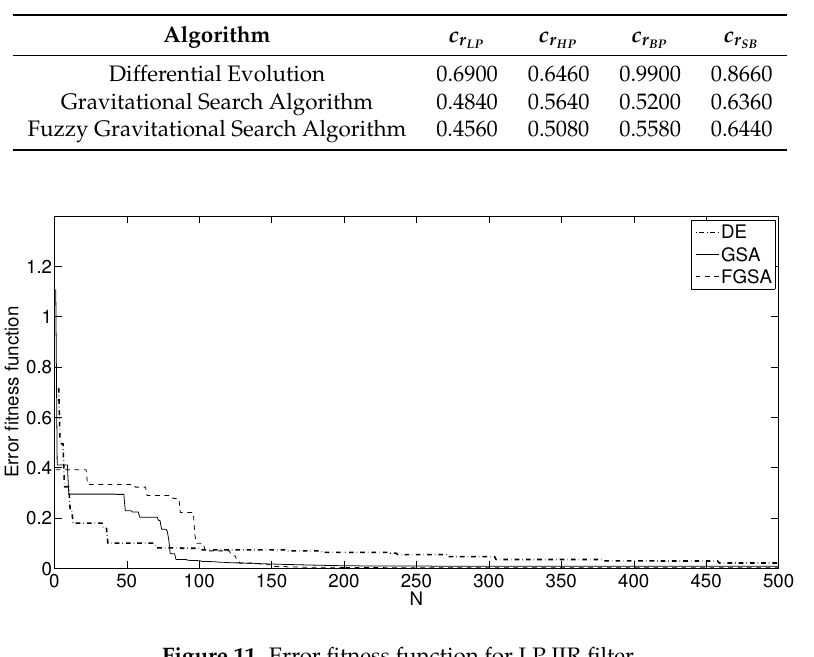
Figure 11. Error fitness function for LP IIR filter.